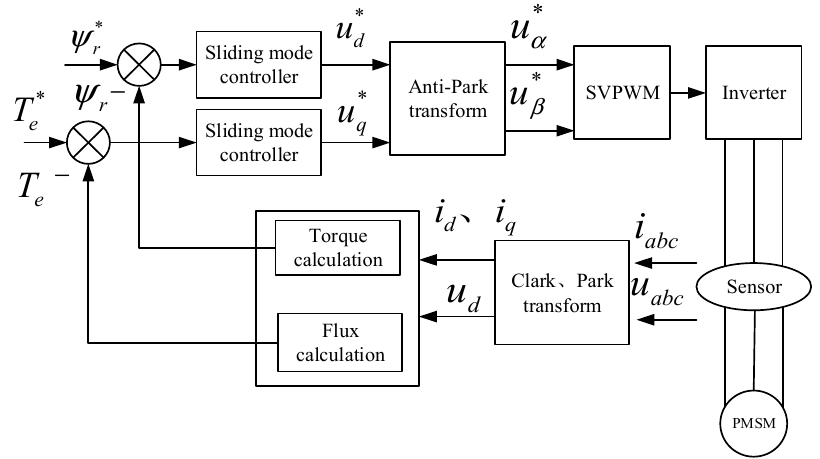
Figure 6. Block diagram of direct torque control based on sliding-mode control.